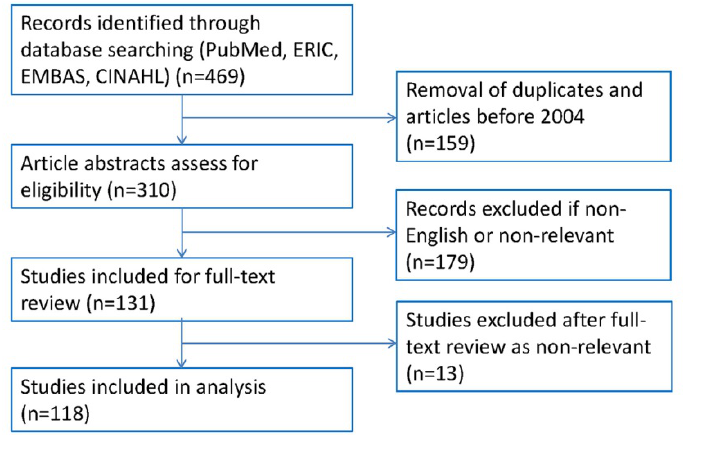
Figure 1 Flowchart of literature search and study selection for multi-institutional health sciences education